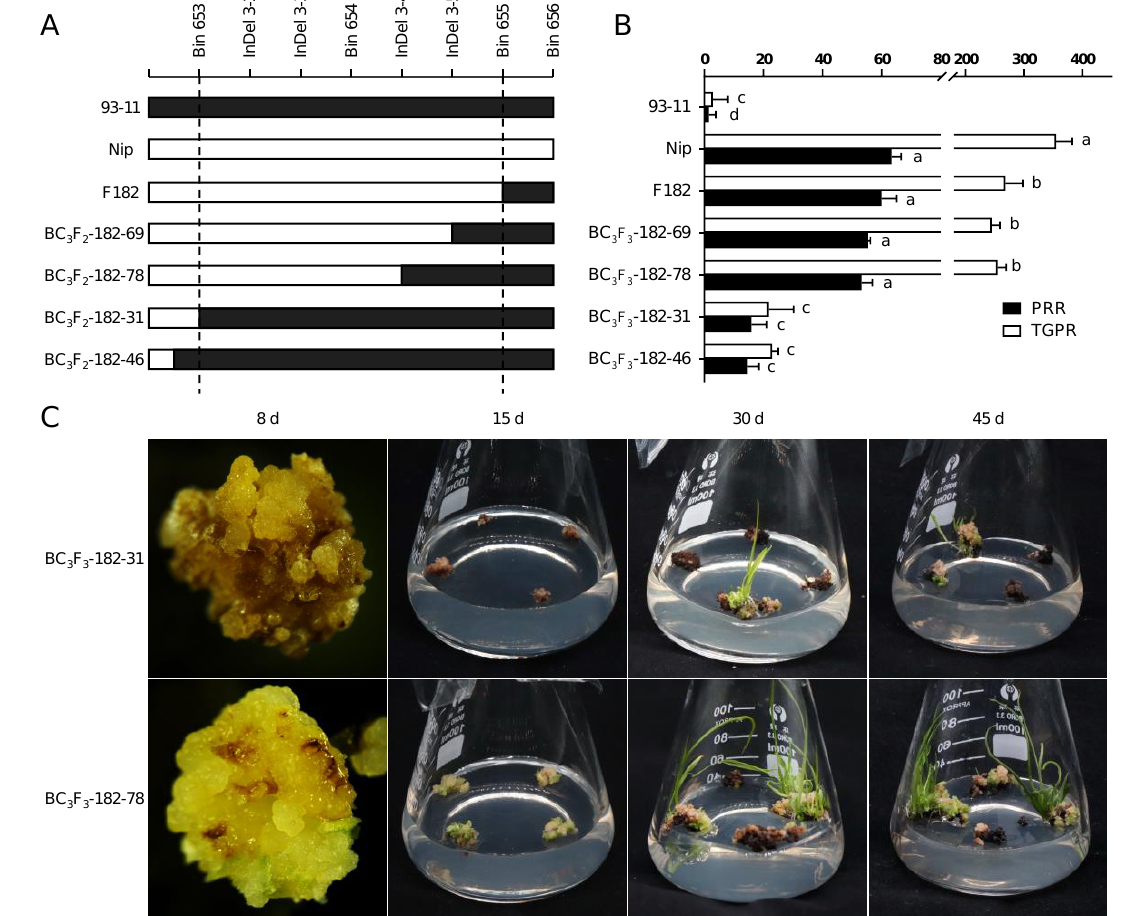
Figure 4. Validation of the effect of qPRR3 . ( A ) Genotypes of recombinant families in parents, F182, and BC 3 F 2 , with cryptographic markers between Bin653 and Bin655. White and black represent the genotype derived from the Nip and 93-11 allele, respectively, all of which are homozygous families. ( B ) Regeneration phenotypes of all families in A with multiple comparisons. Black represents PRR, and white represents TGPR. BC 3 F 2 -182 – 69 and BC 3 F 2 -182 – 78 are homozygous-positive families, and BC 3 F 2 -182 – 31 and BC 3 F 2 -182 – 46 are homozygous-negative families. Different letters near the bars denote significant differences among families ( p < 0.05, ANOVA). ( C ) Upper: regeneration ability of BC 3 F 3 -182 homozygous-negative families. The callus displayed browning and no obvious proliferation at 8 d; only a few plantlets were regenerated and emerged after 30 d; and there was no obvious increase in plantlets until 45 d. Lower: regeneration ability of BC 3 F 3 -182 homozygous-positive families. The callus showed significant proliferation at 8 d; green spots appeared at 15 d; regenerated plantlets were observed at 30 d; and a large number of regenerated plantlets could be observed at 45 d.